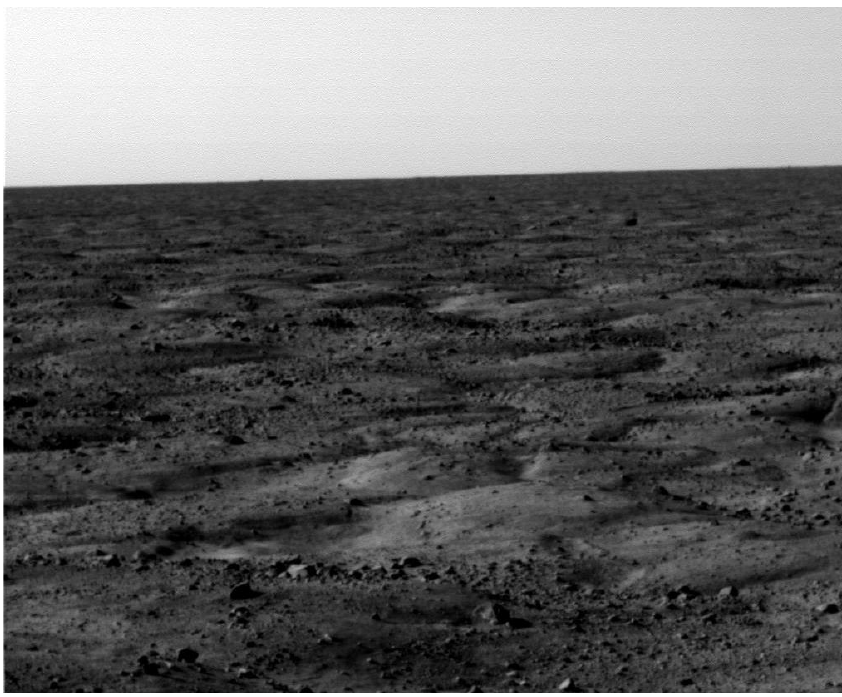
Figure 19. Permafrost polygons imaged by the Phoenix lander.